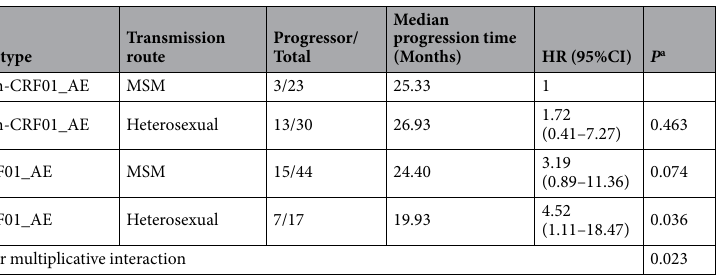
Table 3. The interaction between HIV-1 subtypes and transmission route on HIV/AIDS progression. a P value of interaction analysis between HIV-1 subtype and transmission route on HIV/AIDS progression with adjustment for gender, age at infection and baseline CD4